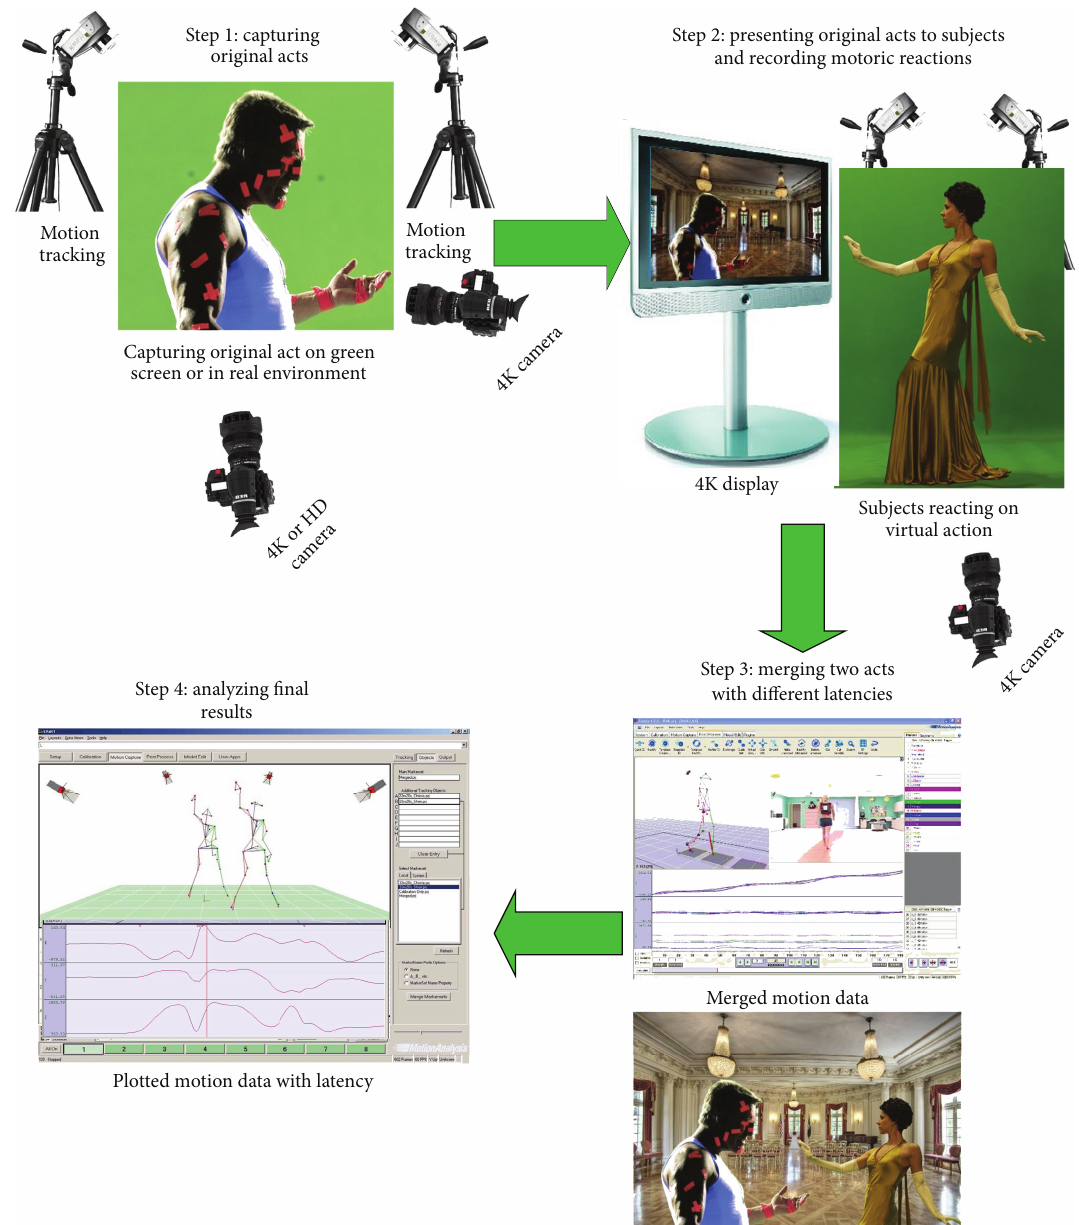
Figure 1: Work flow of the experiment (photograph that is courtesy of Dimension Films and Troublemaker Studios has been edited and used for illustrative